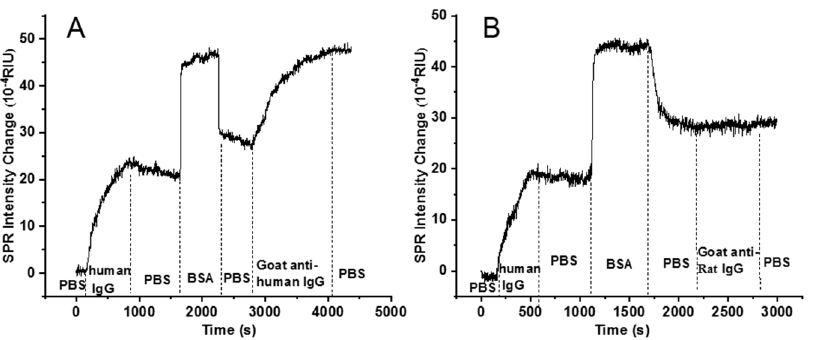
Figure 3. The curve of binding process. ( A ) Human IgG antigen and goat anti-human IgG antibody; ( B ) human IgG antigen and the goat anti-rat IgG antibody.